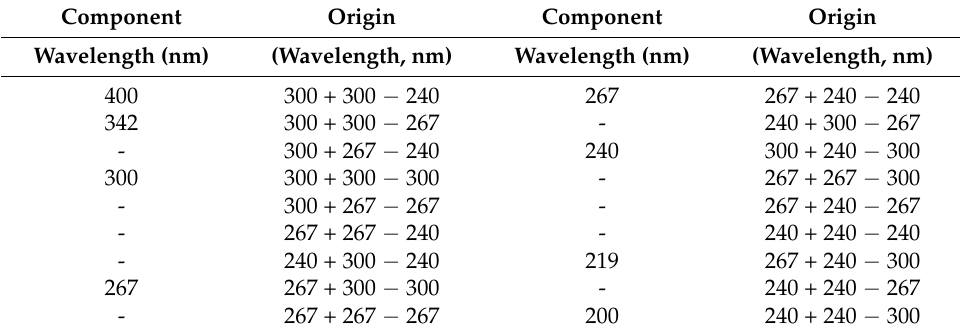
Table 1. Origins for the generation of the components in the FROG trace.